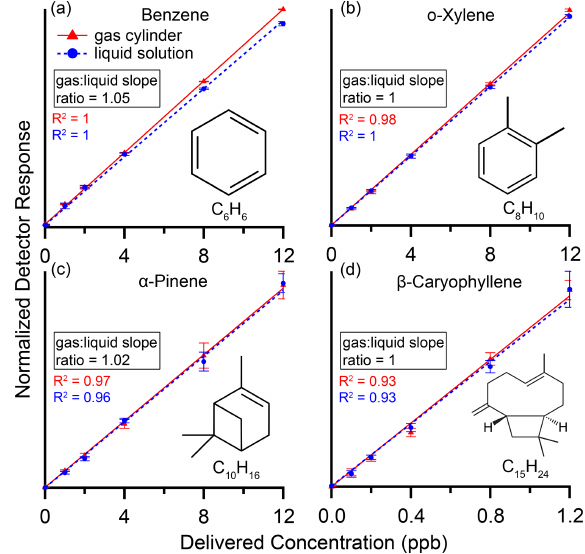
Figure 4. Calibration curves with R 2 values for (a) benzene, (b) o - xylene, (c) α -pinene and (d) β -caryophyllene in a gas cylinder (red) and in a custom liquid mixture (blue), delivered by the dynamic di- lution system (Fig. 3). Normalized detector response on the y axis is the integrated area of the chromatographic peak divided by that of neohexane, our internal standard, on the same chromatogram. Max- imum normalized detector response for a given compound ranged from 0.030 ( β -caryophyllene, max concentration delivered 1.2ppb) to 3.0 ( o -xylene, max concentration delivered 12ppb). Addition- ally, for benzene all data points had the mean of the 0ppb values subtracted. Points are mean values of the individual samples at each level with error bars representing plus or minus 1 standard devia- tion. Dotted lines are best-fit lines forced through the origin, while R 2 values are from best fits not forced through the origin. Com- pounds show excellent linearity and agreement within 5% between the gas cylinder and liquid